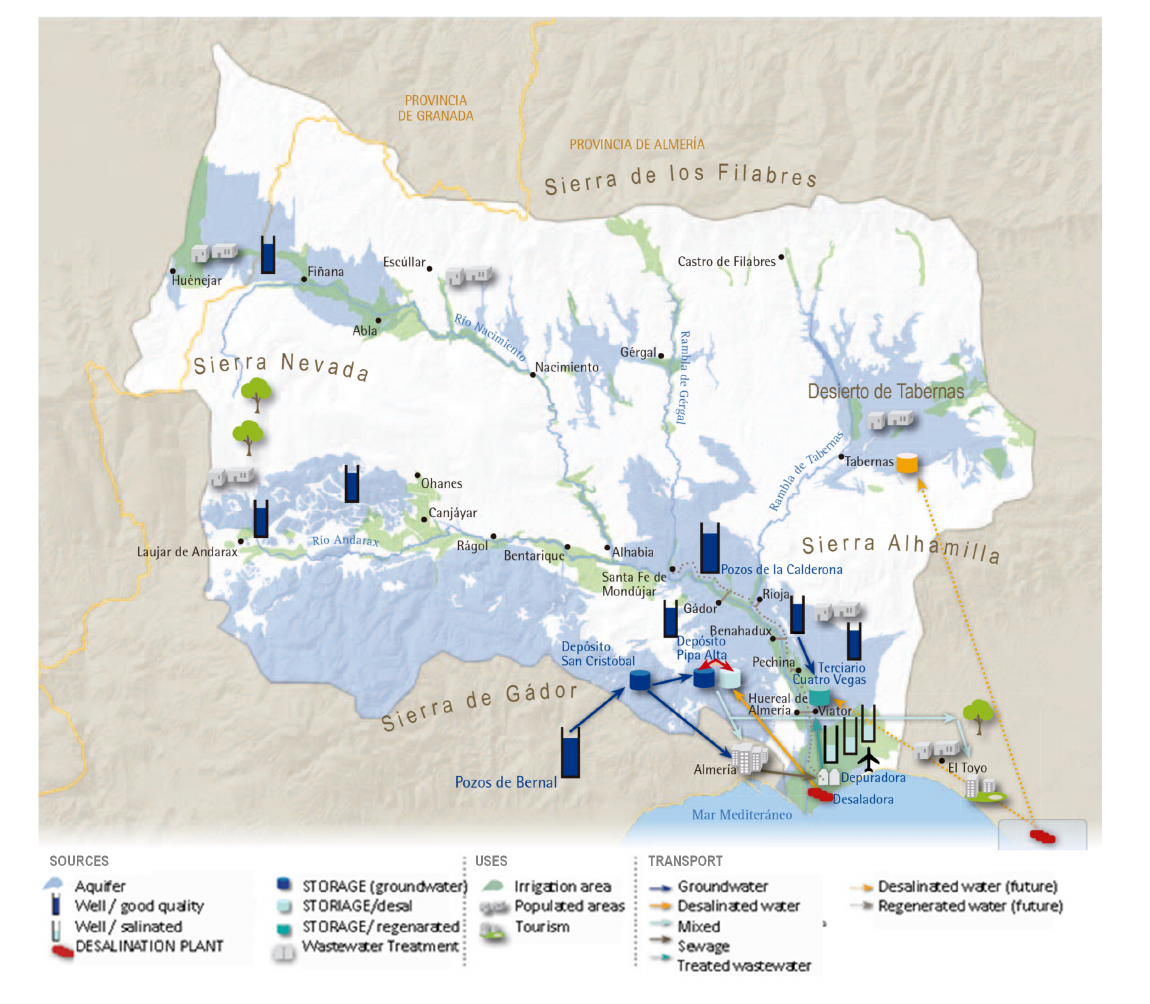
Fig. 1. Andarax river basin, schematic of water sources, uses, and